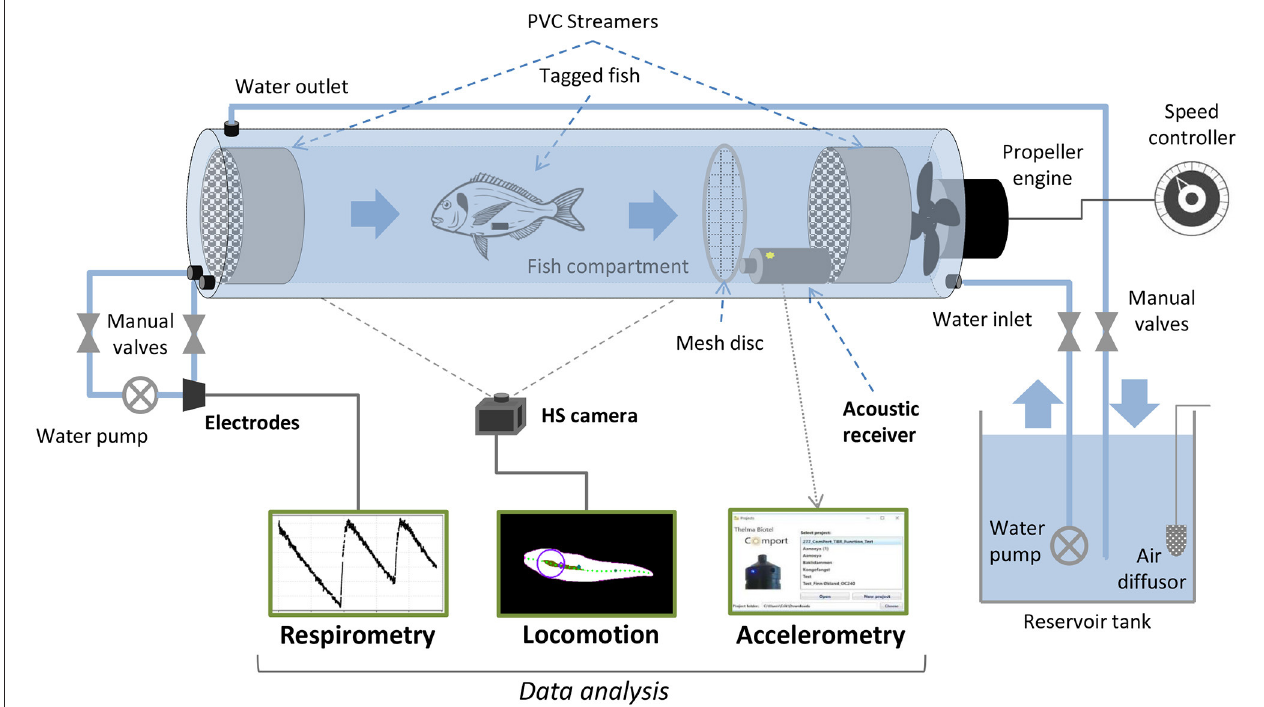
FIGURE 1 | Schematic drawing of a Blažka-type swim-tunnel (modified and adapted from Van Den Thillart et al., 2004) with the experimental setting for accelerometry, respirometry and locomotion assessment of Sparus aurata at different swimming speeds in the present work.